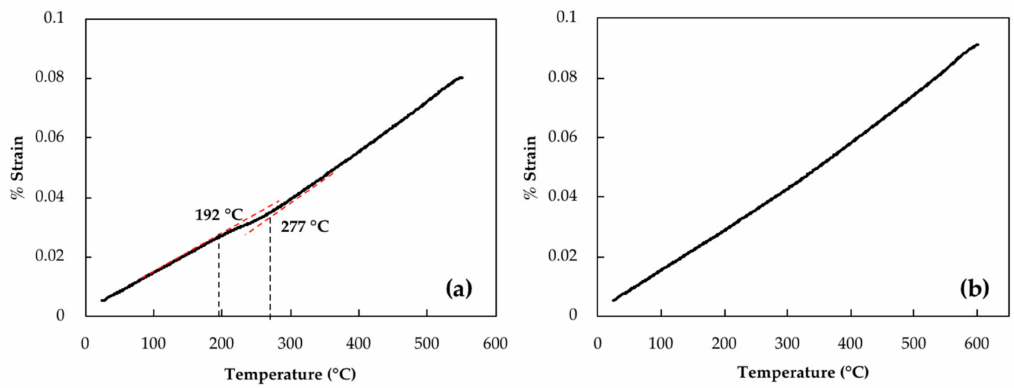
Figure 3. Dilatometry curves of cooling cycle with cooling rate of 600 ◦ C/min after isothermal tempering for 16 h at ( a ) 550 ◦ C and ( b ) 600 ◦ C.